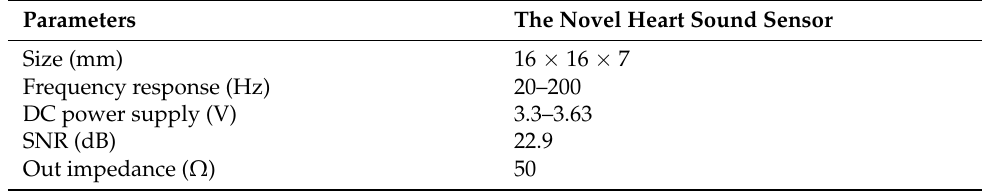
Table 2. Features of the novel heart sound sensor.